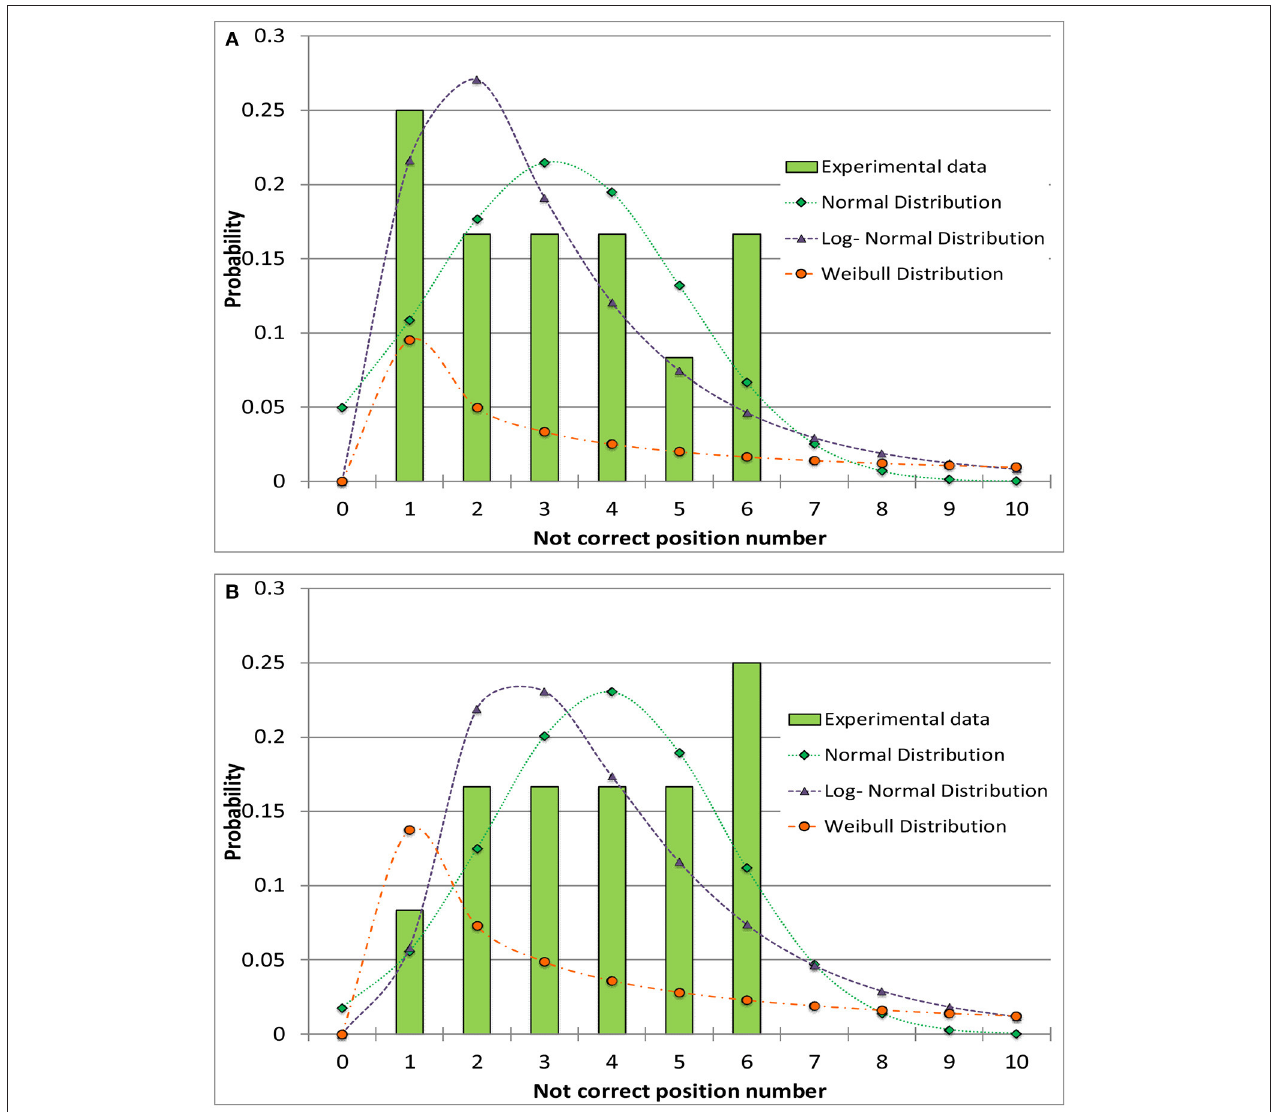
FIGURE 4 | Comparison between different distribution functions and the experimental data for the incorrect positioning of thermocouples in the 4R (16mm diameter) vials. (A) Before the shift of the tray. (B) After the shift of the tray.